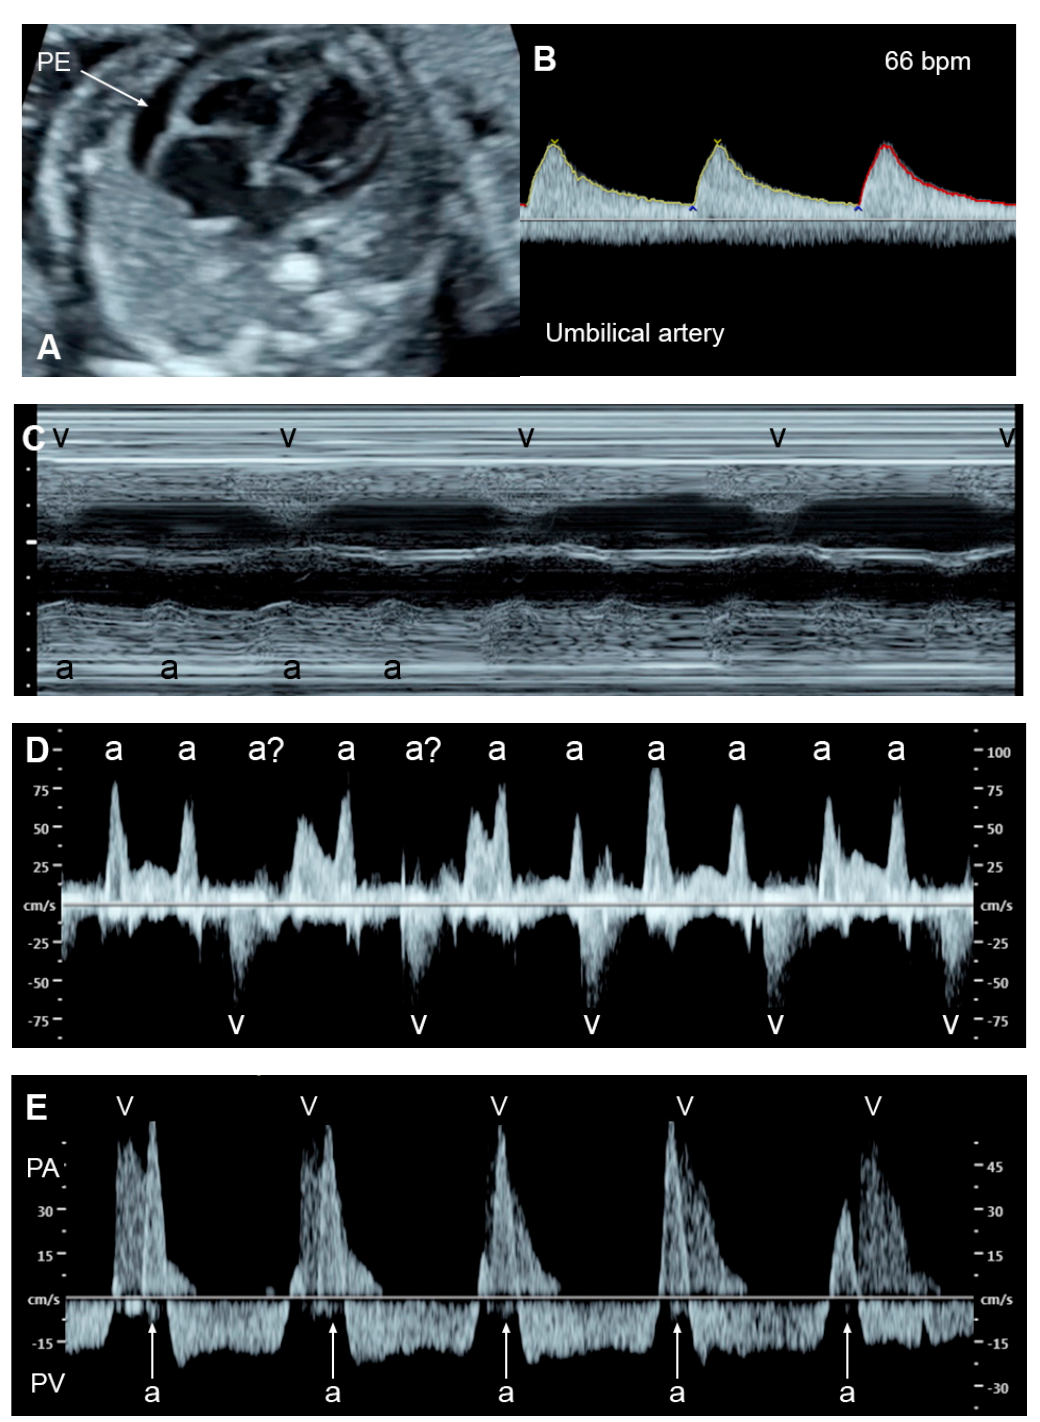
Figure 3. Complete heart block: ( A ) slightly enlarged heart with pericardial effusion (PE); ( B ) Ven- tricular rate of 66 bpm in the umbilical artery; ( C – E ) dissociations between atrial and ventricular contraction with ventricular bradycardia in M-mode ( C ) cardiac Doppler ( D ), and PW-Doppler of the pulmonary artery (PA) and pulmonary vein (PV) ( E ). Fetuses with an AV block make attempts to increase compensatory ventricular stroke volumes to maintain adequate cardiac output. Nevertheless, some cannot tolerate such